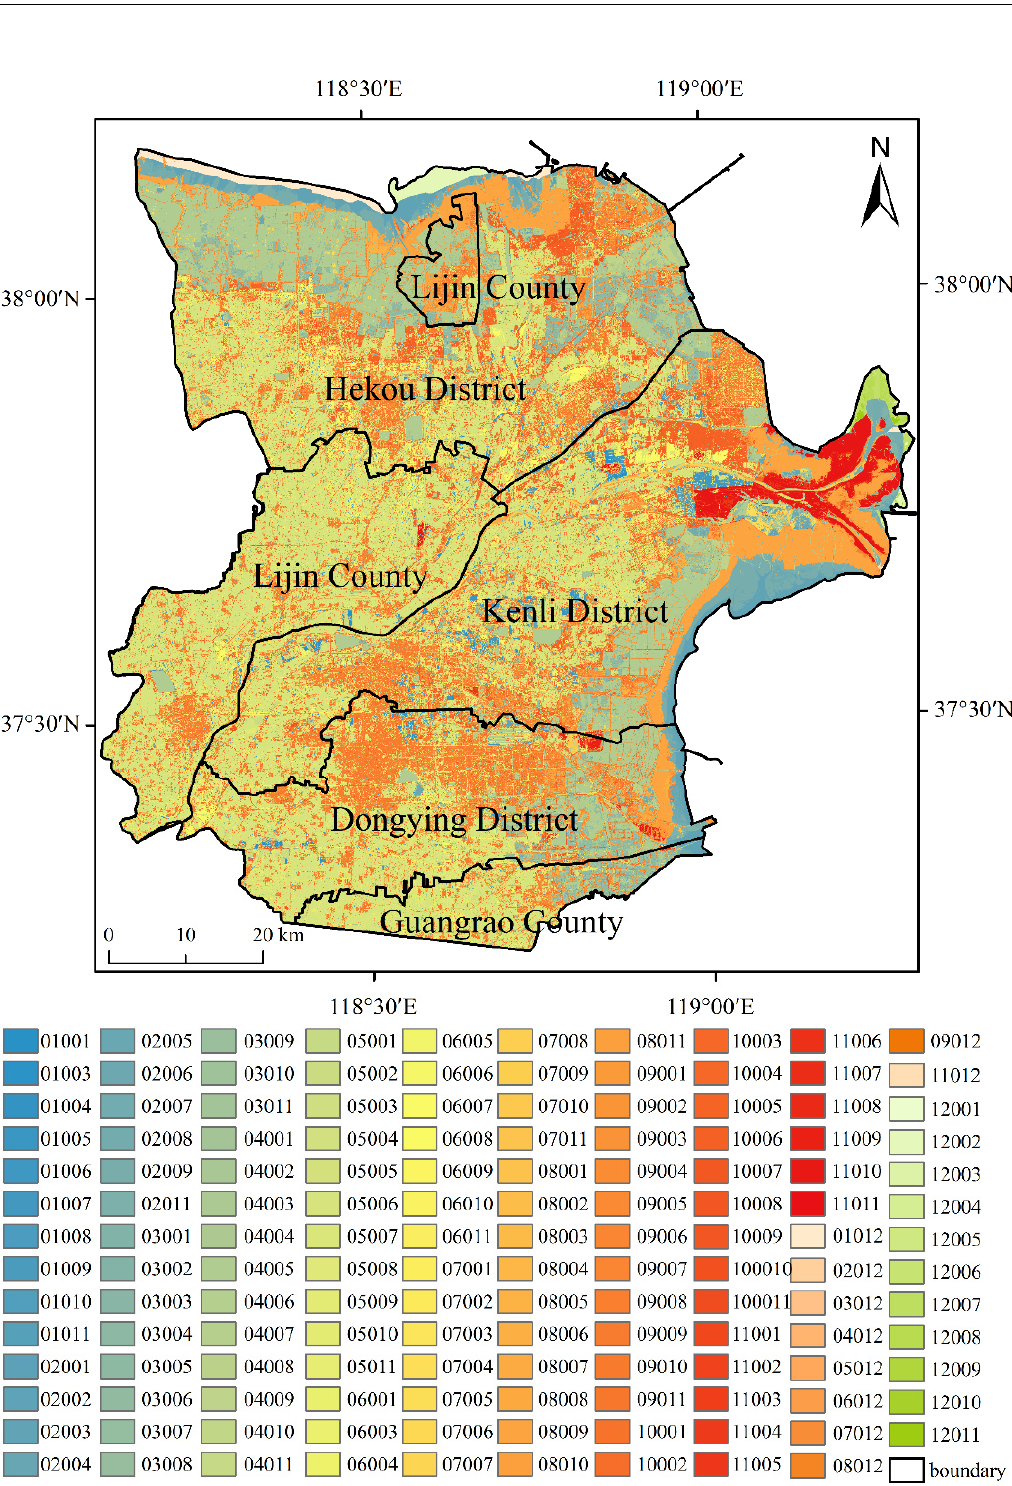
Figure 8. Spatial distributions of secondary classification changes during 2015–2021.